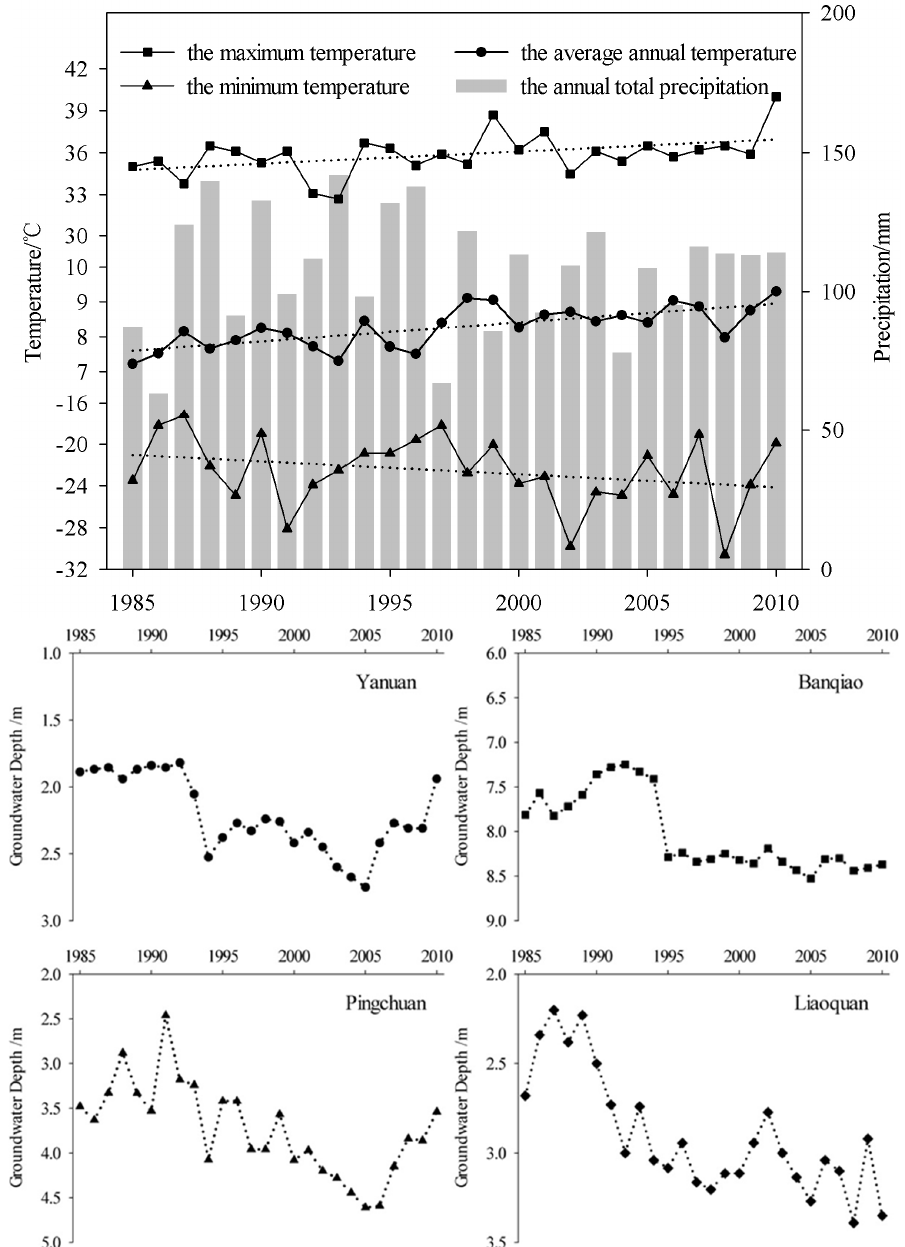
Figure 2. Change of annual total precipitation, annual temperature and annual groundwater depth between 1985 and 2010.